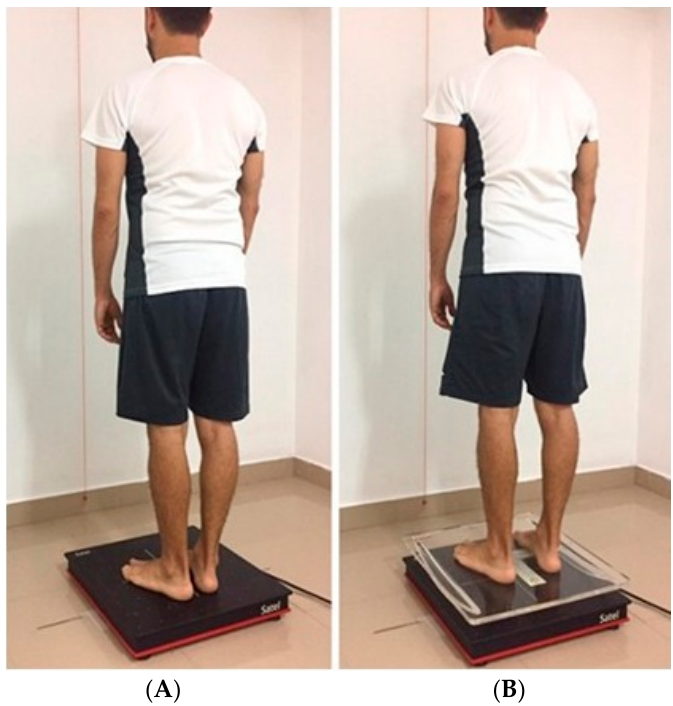
Figure 2. ( A ) Assessing quiet stance; ( B ) Assessing dynamic